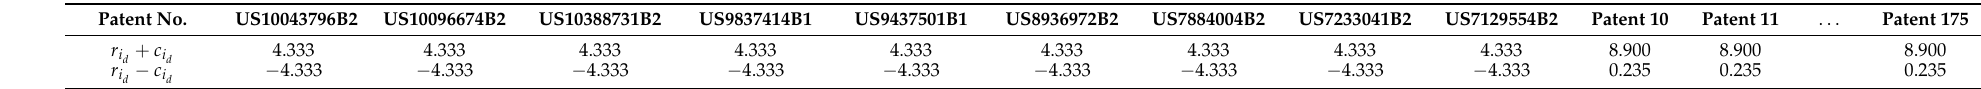
+ c − c i d and r i d i d of the second empirical case (Unit: 10 d